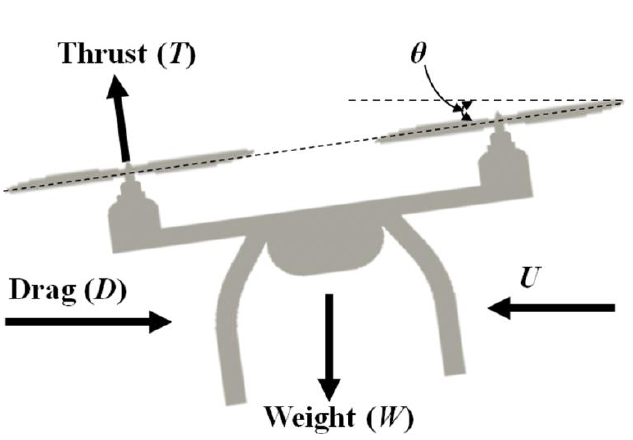
Figure 2. Schematics of a planar view for a forward flight drone.